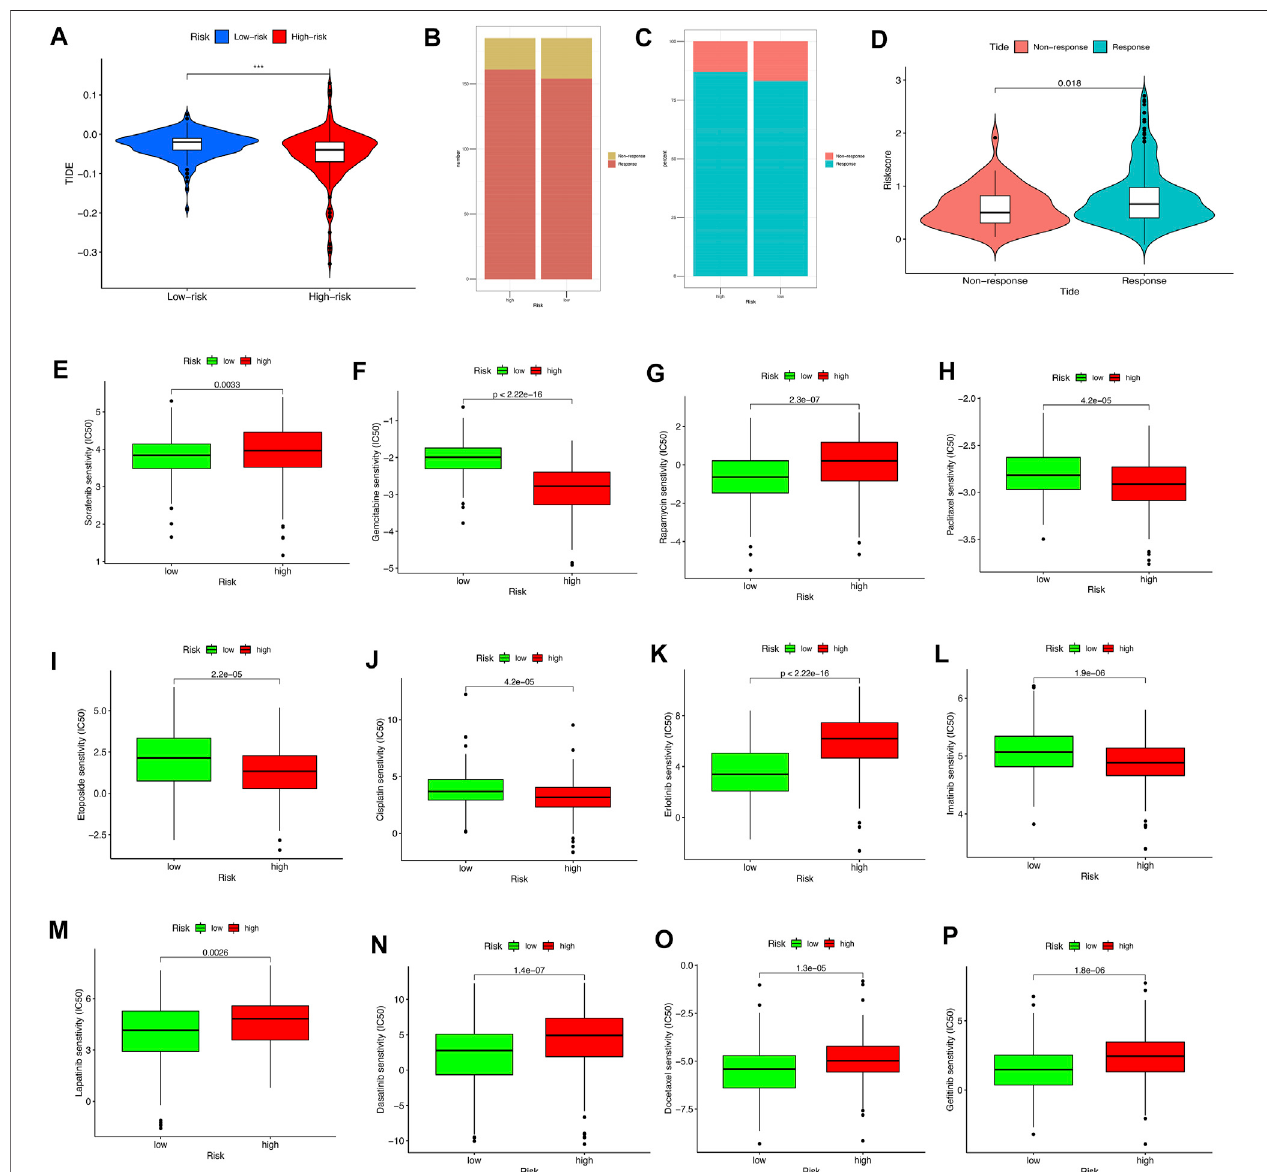
FIGURE 9 | The relationship between the different risk groups and chemotherapeutic ef fi cacy. (A) Comparison of the Tumor Immune Dysfunction and Exclusion (TIDE) prediction scores in the low- and high-risk groups. (B,C) Distribution and percentage of immunotherapy response among risk groups of HCC patients. (D) Comparison of risk scores between the response group and the nonresponse group. (E – P) Sensitivity analysis of drugs between different risk groups.